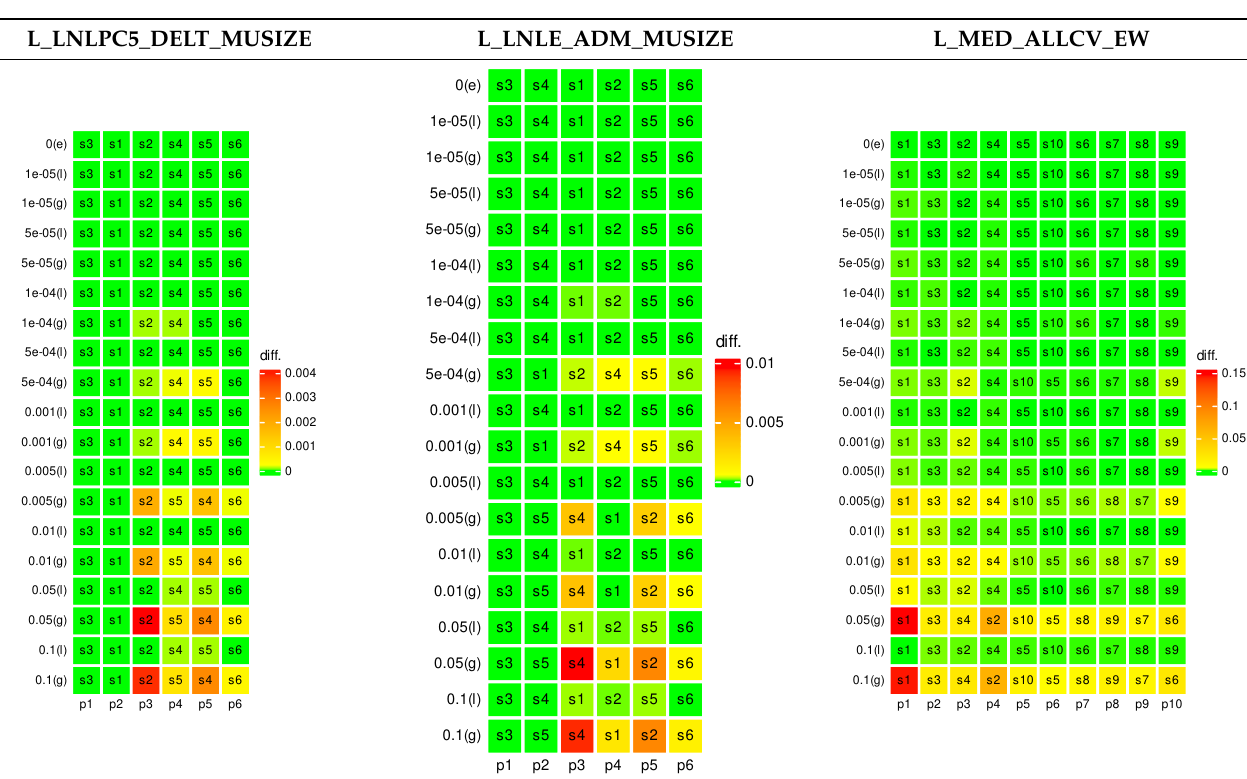
Table 18. Preferences for munin